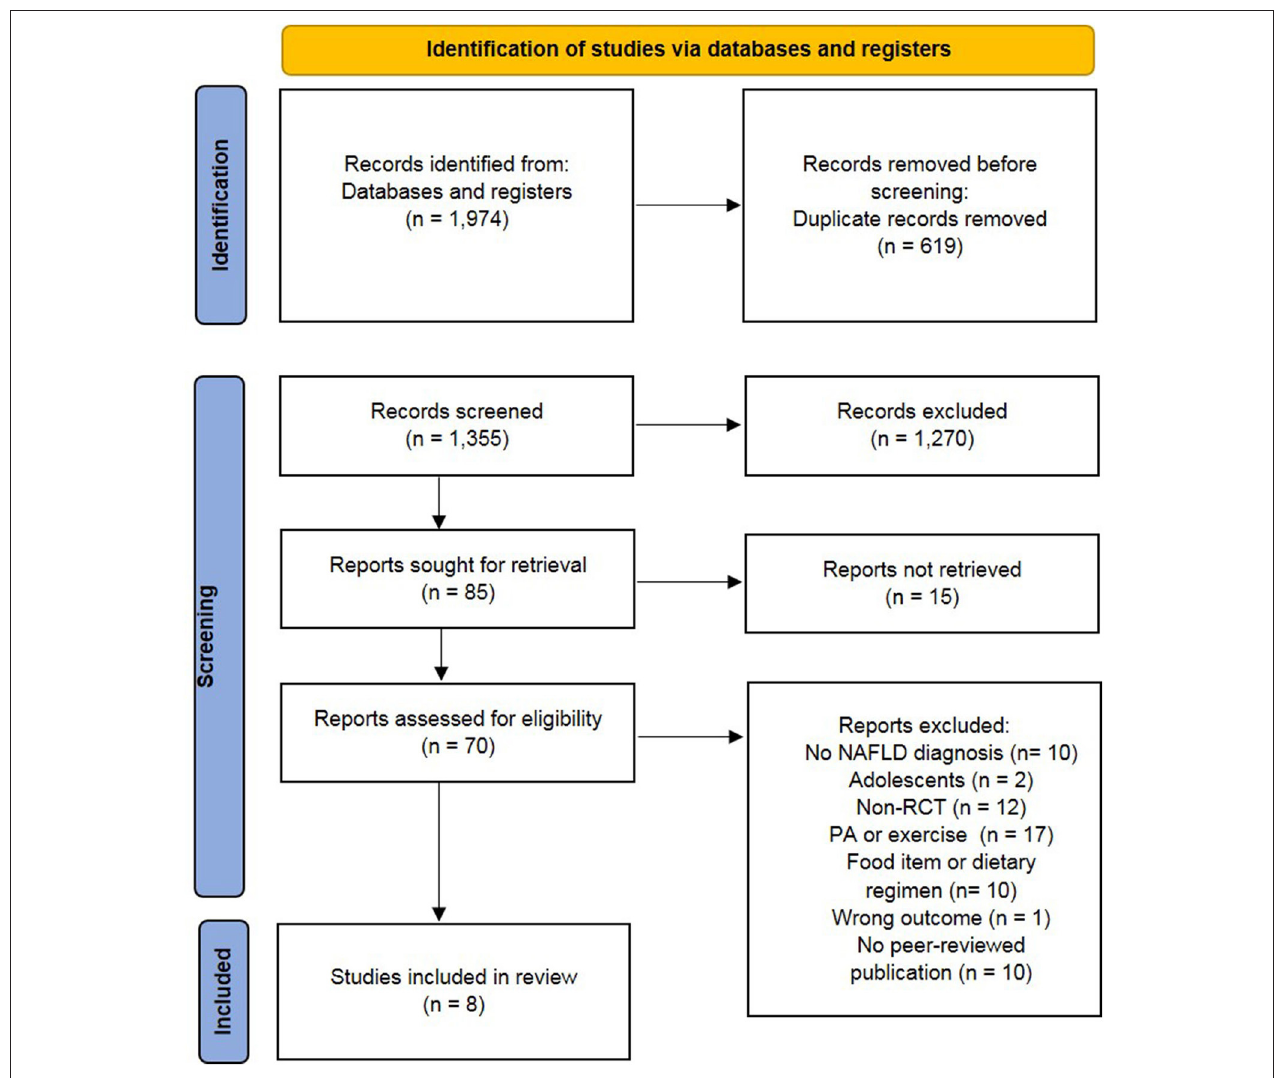
FIGURE 1 | Preferred reporting items of systematic reviews and meta-analysis (PRISMA) flow chart (34). NAFLD, non-alcoholic fatty liver diseases; non-RCT, non-randomized controlled trial; PA, physical